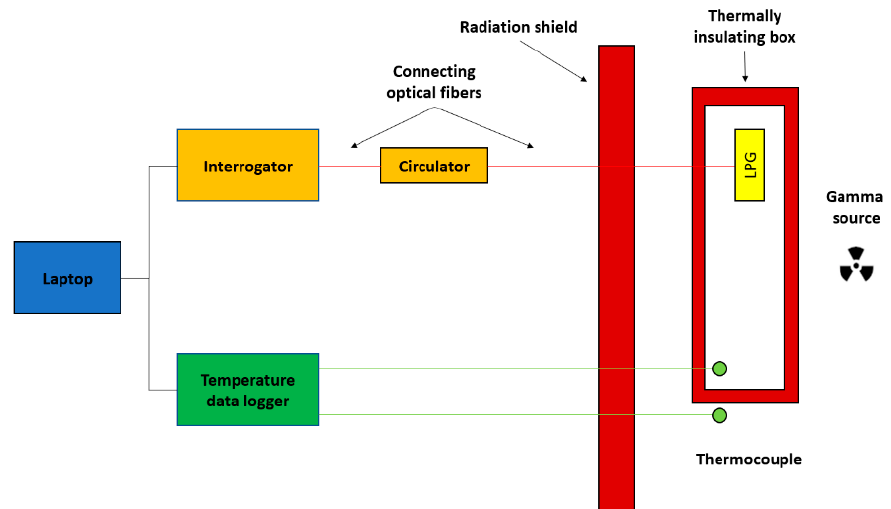
Figure 1. Irradiation setup utilizing the SVST Co-60 / B irradiator. The irradiation zone and interrogation setup are separated by a concrete radiation shield. Long period gratings (LPGs) are placed in a thermally insulated box in the proximity of the Co-60 source, with thermocouple reference sensors.